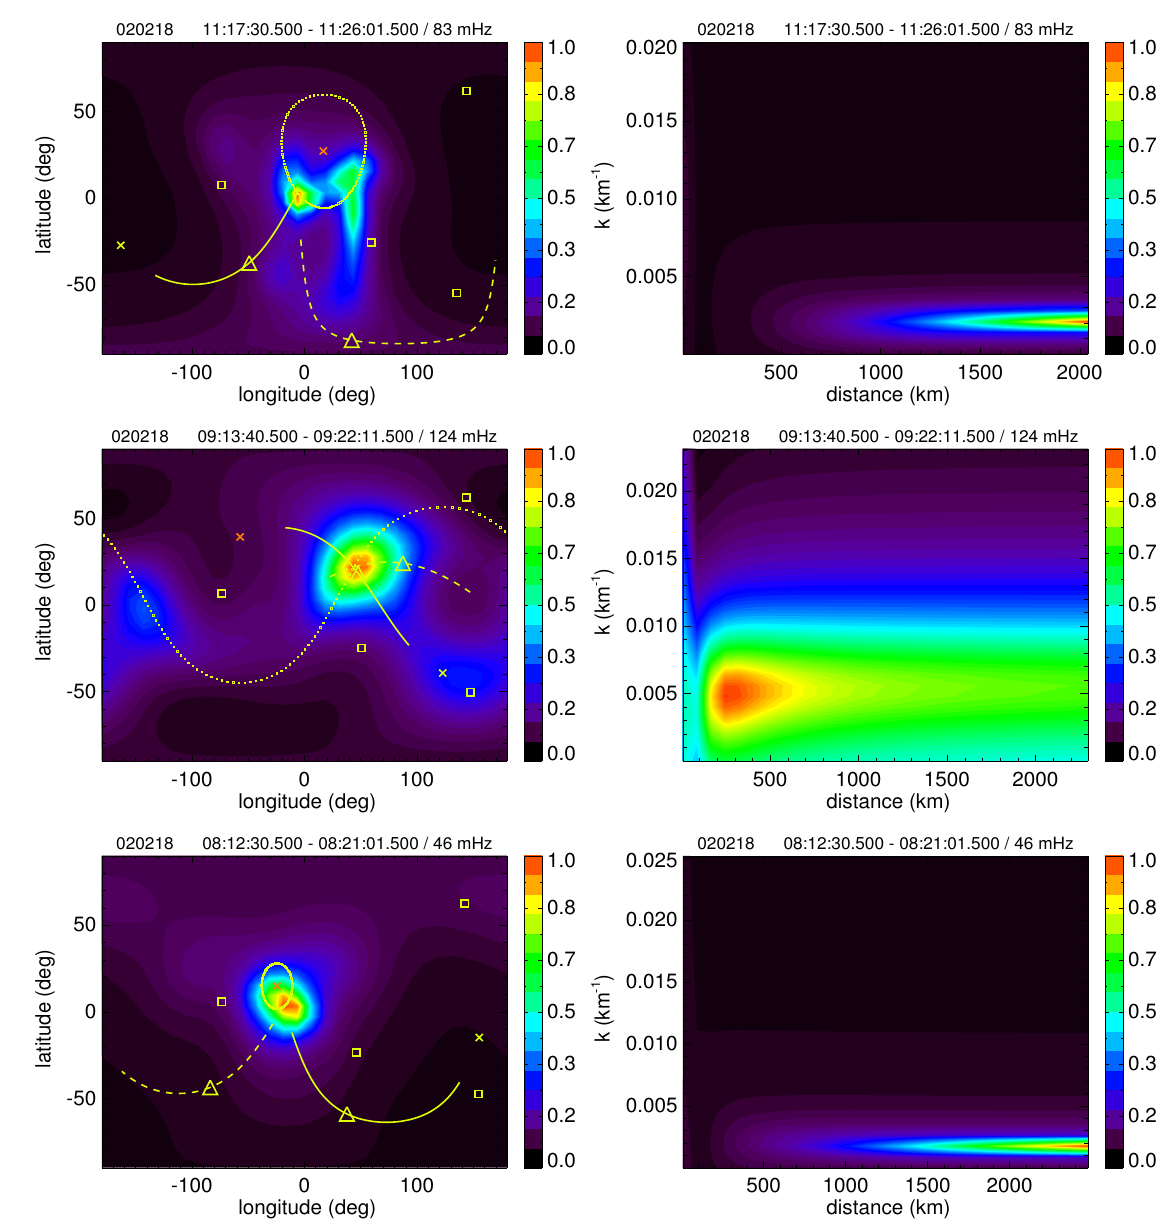
Fig. 5. Array power for data samples in different magnetospheric regions. From top to bottom: ion foreshock (II), electron foreshock, and ion foreshock (I). The ion foreshock (II) wave propagates oblique from a remote source. The local generated electron foreshock wave propagates orthogonal to the mean magnetic field. In the ion foreshock (I) a parallel propagating plane wave is detected.